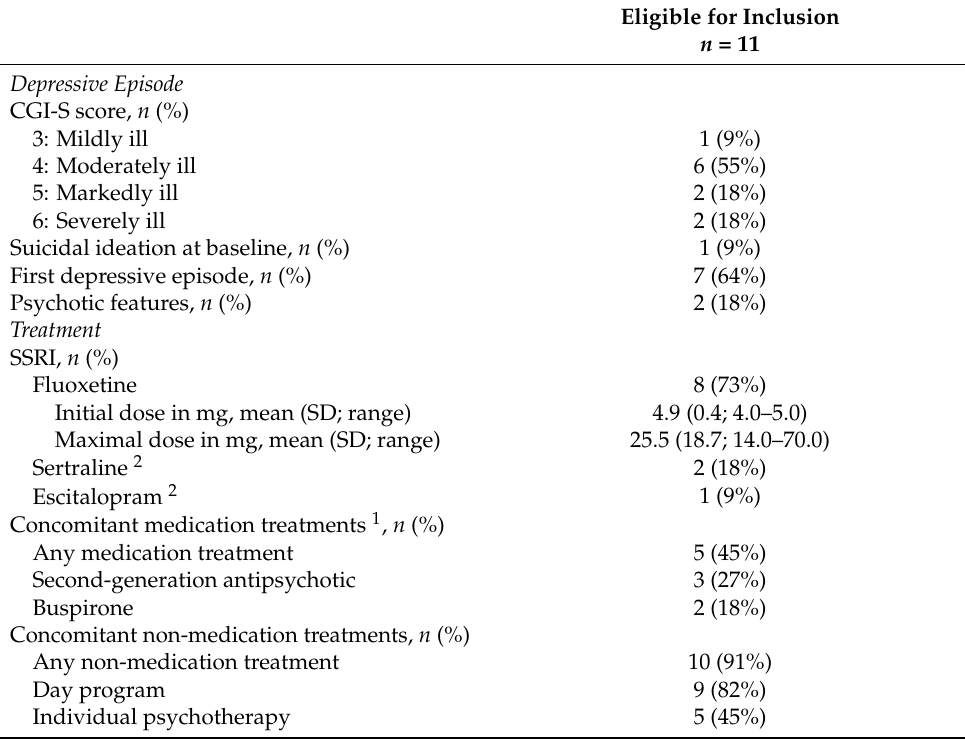
Table 2. Characteristics of Depressive Episodes and Treatment.